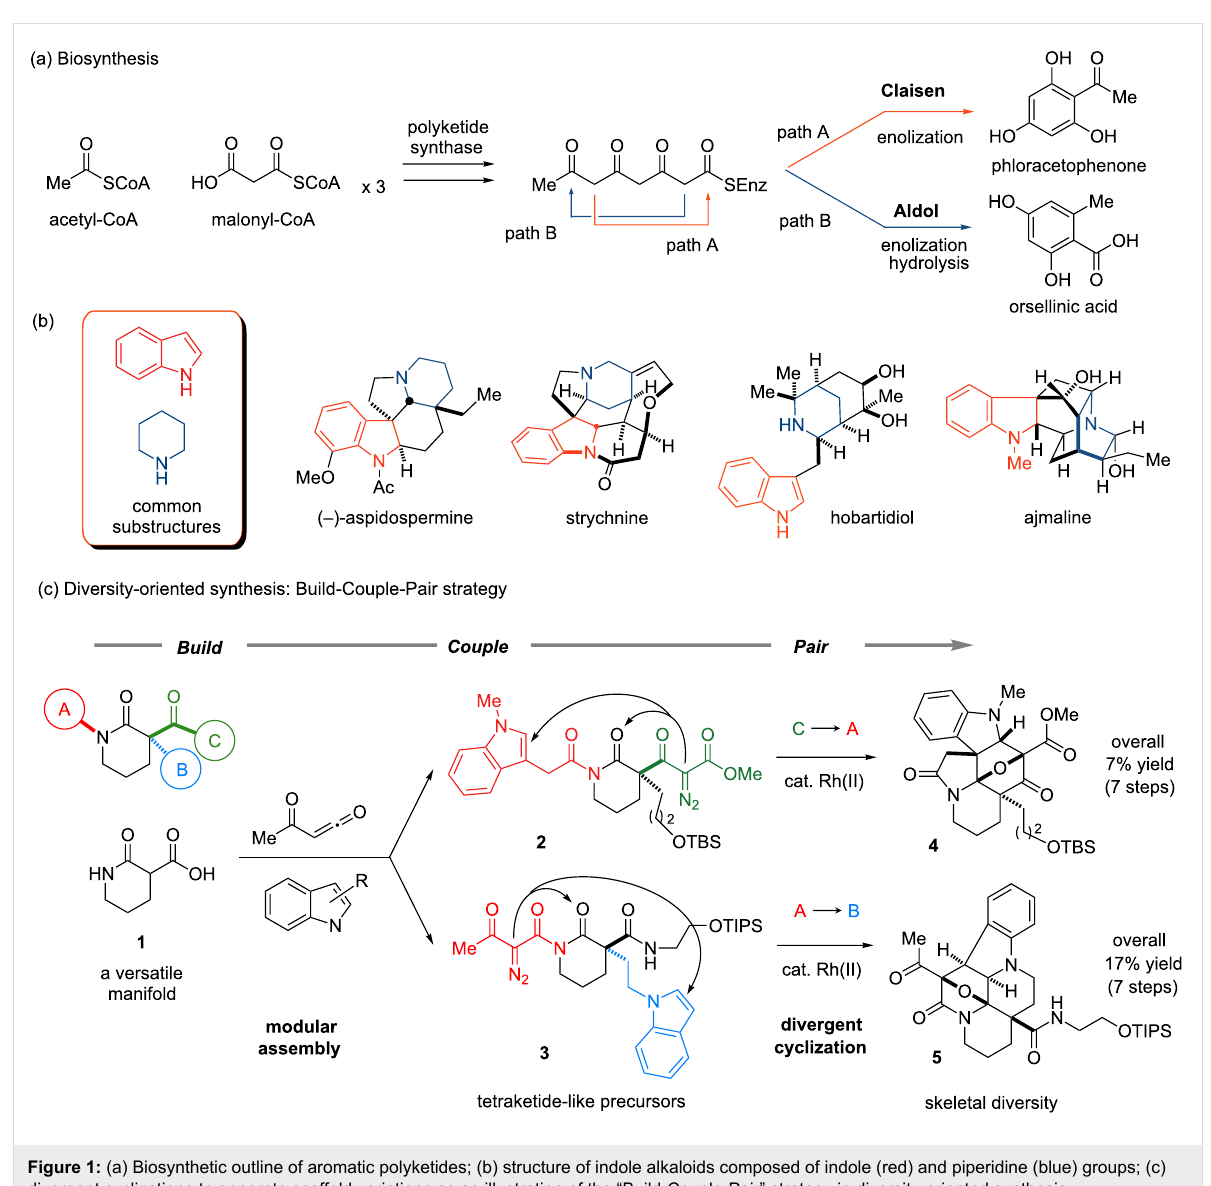
Figure 1: (a) Biosynthetic outline of aromatic polyketides; (b) structure of indole alkaloids composed of indole (red) and piperidine (blue) groups; (c) divergent cyclizations to generate scaffold variations as an illustration of the “Build-Couple-Pair” strategy in diversity-oriented